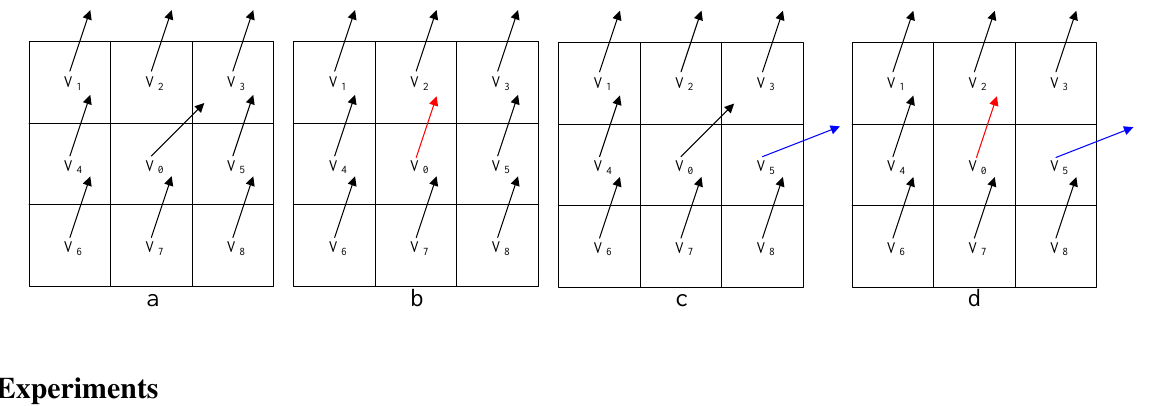
Figure 6. LMS smoothing. ( a ) The raw filtering results. If the central grid is abnormal, but all of its neighbors are normal, it will be corrected either under the criteria of Equation (16) or the criteria of Equation (17), as shown in ( b ). However, if one of its neighboring grids is more abnormal ( c ) by v , it will not be corrected under the criteria of Equation (16), but will 5 be corrected under the proposed criteria of Equation (17) ( d